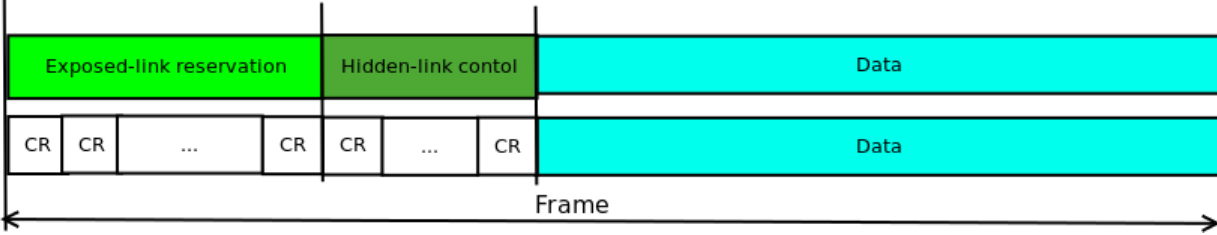
Figure 2. Successful data transmission frame structure for the proposed